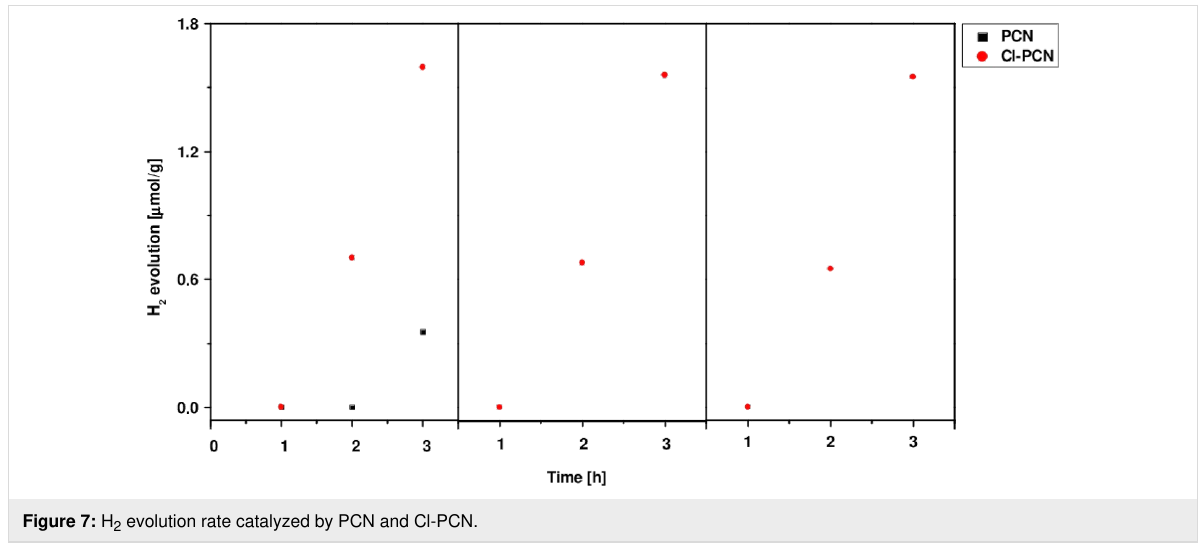
Figure 7: H 2 evolution rate catalyzed by PCN and Cl-PCN.